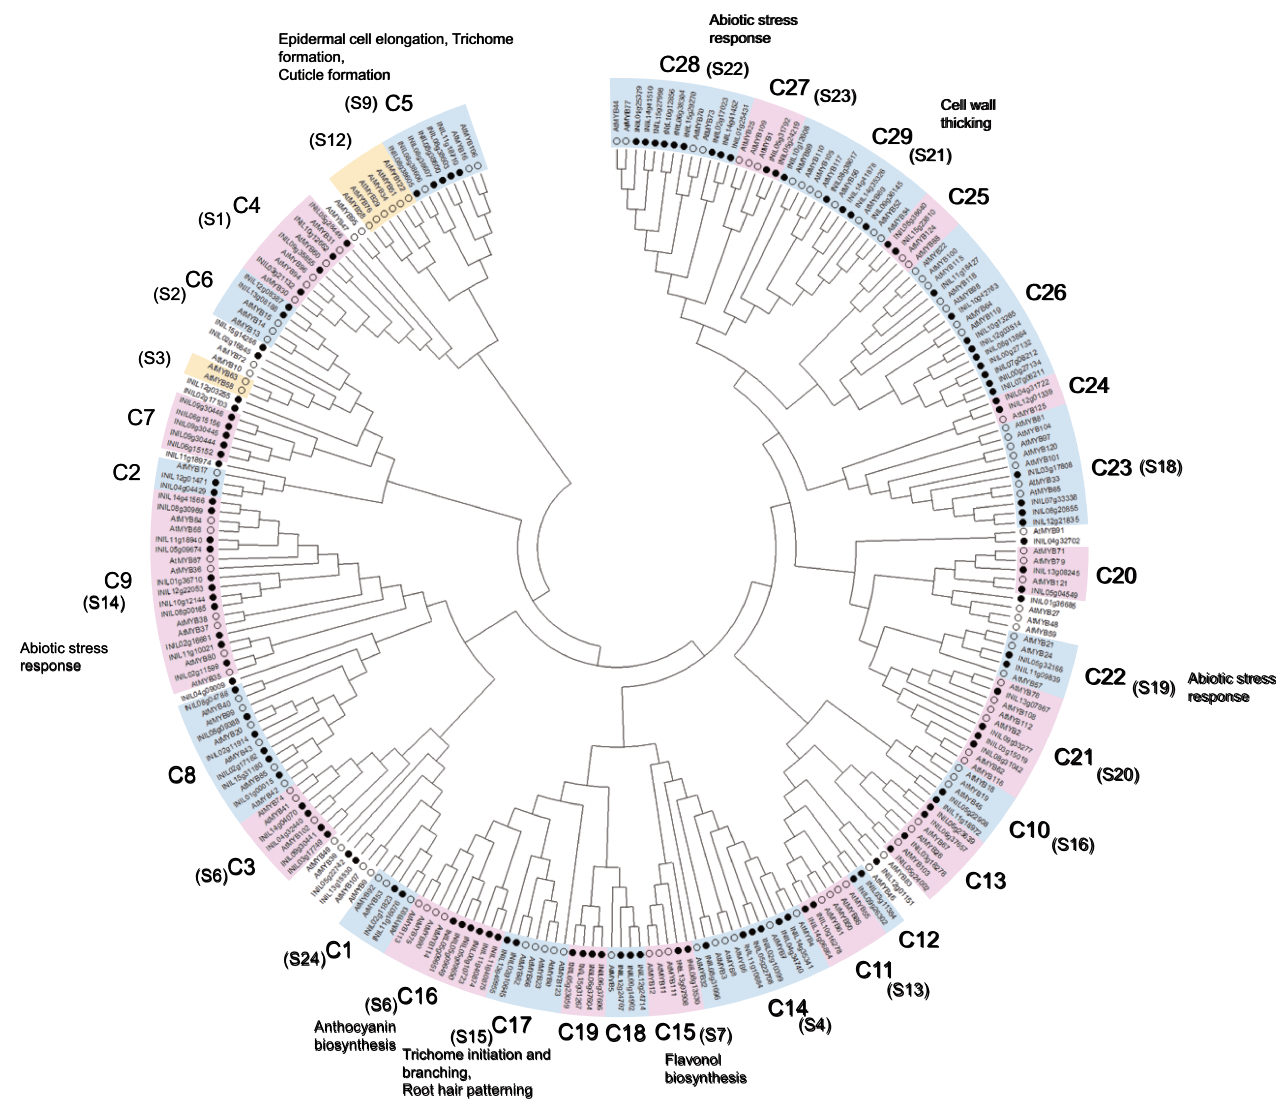
Fig 1. Phylogenetic tree of the R2R3-MYBs of Japanese morning glory and Arabidopsis . Phylogenetic tree was generated by the neighbor-joining method derived from a CLUSTAL alignment of the amino acid sequences of Arabidopsis [9] and Japanese morning glory R2R3-MYBs. The hollow circles represent the Arabidopsis R2R3-MYBs, whole the solid black circles represent the Japanese morning glory R2R3-MYBs. The functions of Arabidopsis R2R3-MYBs [9] were described.